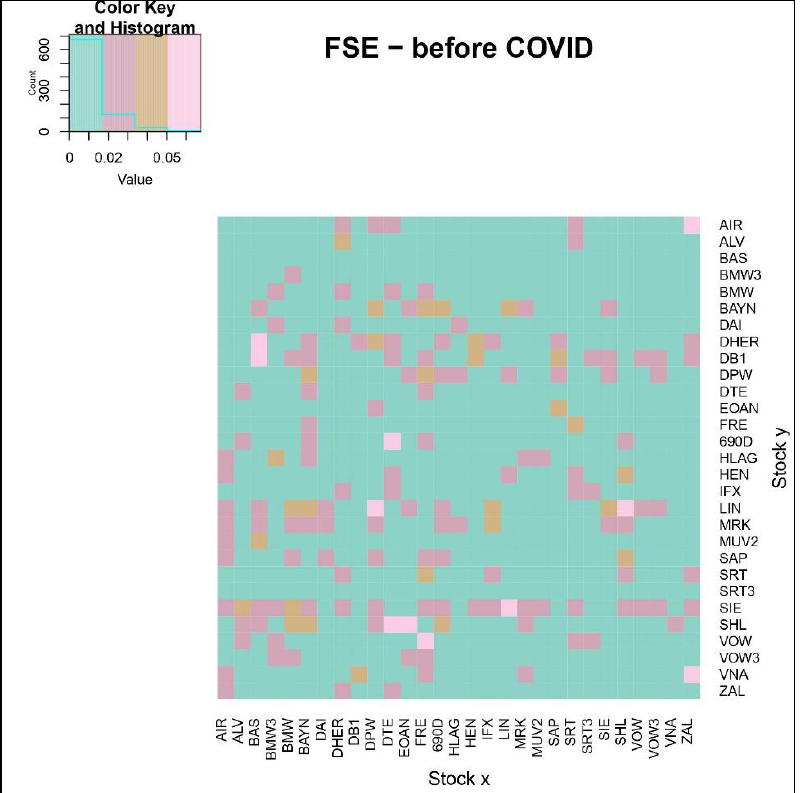
Figure 5. The information flow (effective transfer entropy) from stock y to stock x, for the top companies (by market capitalization) in the FSE market, before the COVID-19 outbreak